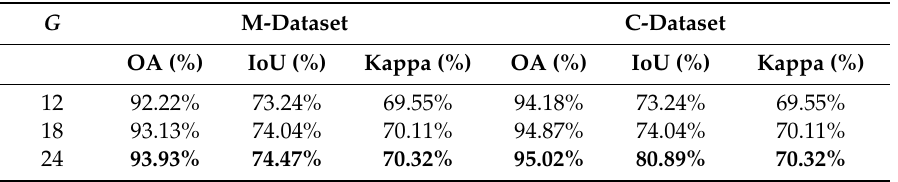
Table 4. Results of different growth factors.